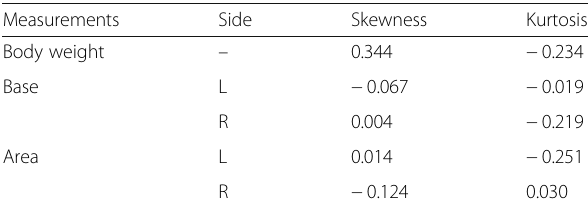
Table 2 Skewness and kurtosis of body weight, base of gait, and area swept in one stride